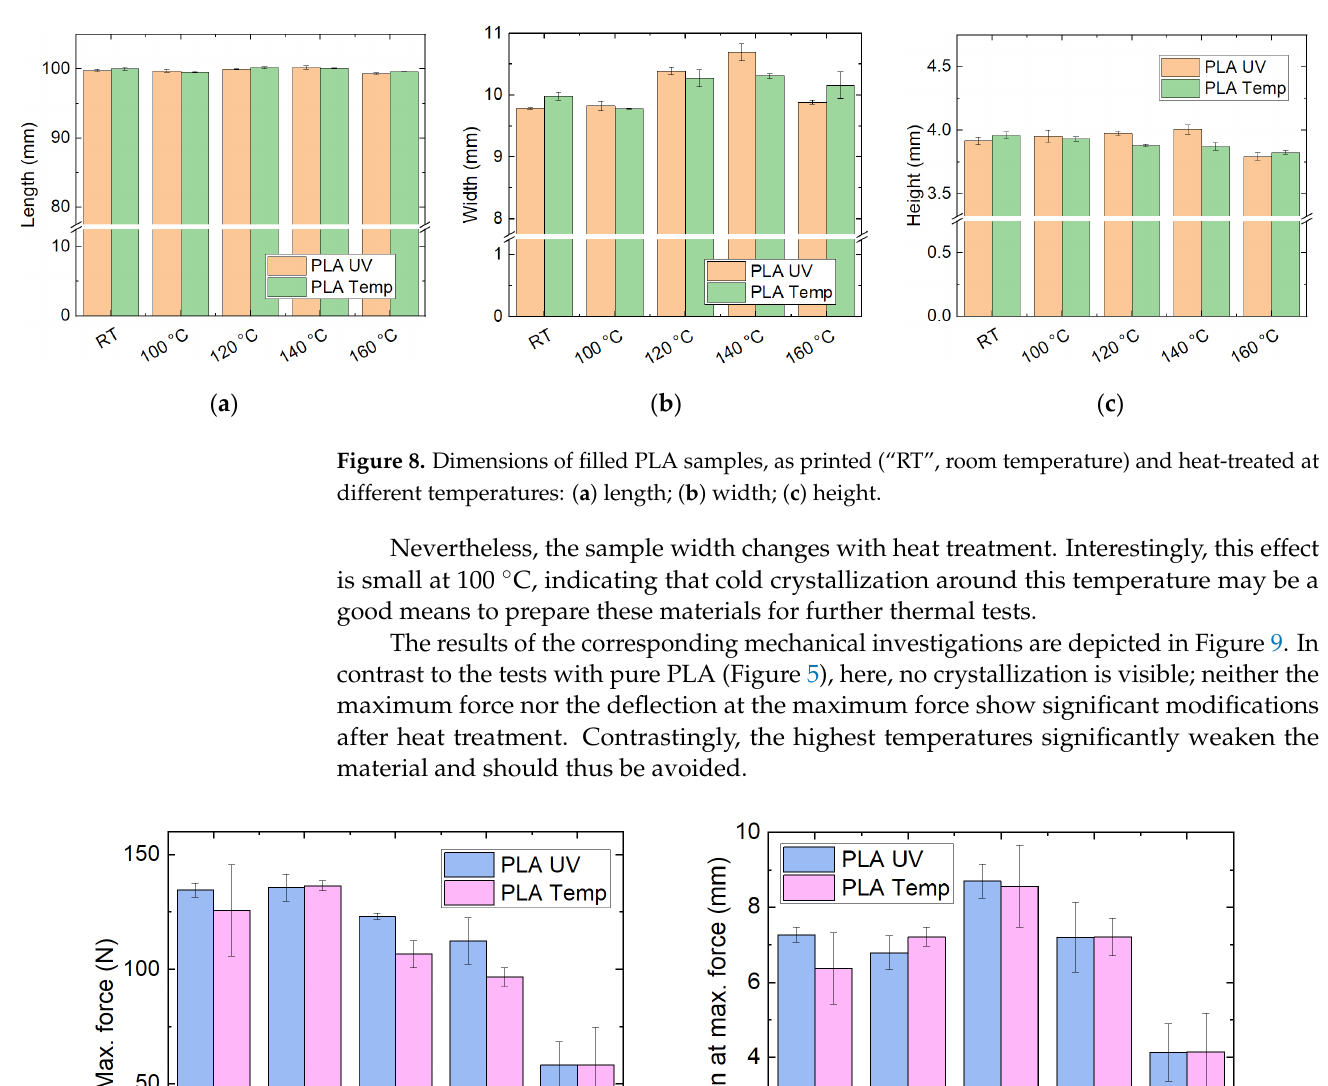
Figure 7. Mechanical properties of HDglass samples, as printed (RT) and heat-treated at different temperatures: ( a ) maximum force; ( b ) deflection at maximum force in 3-point bending tests.